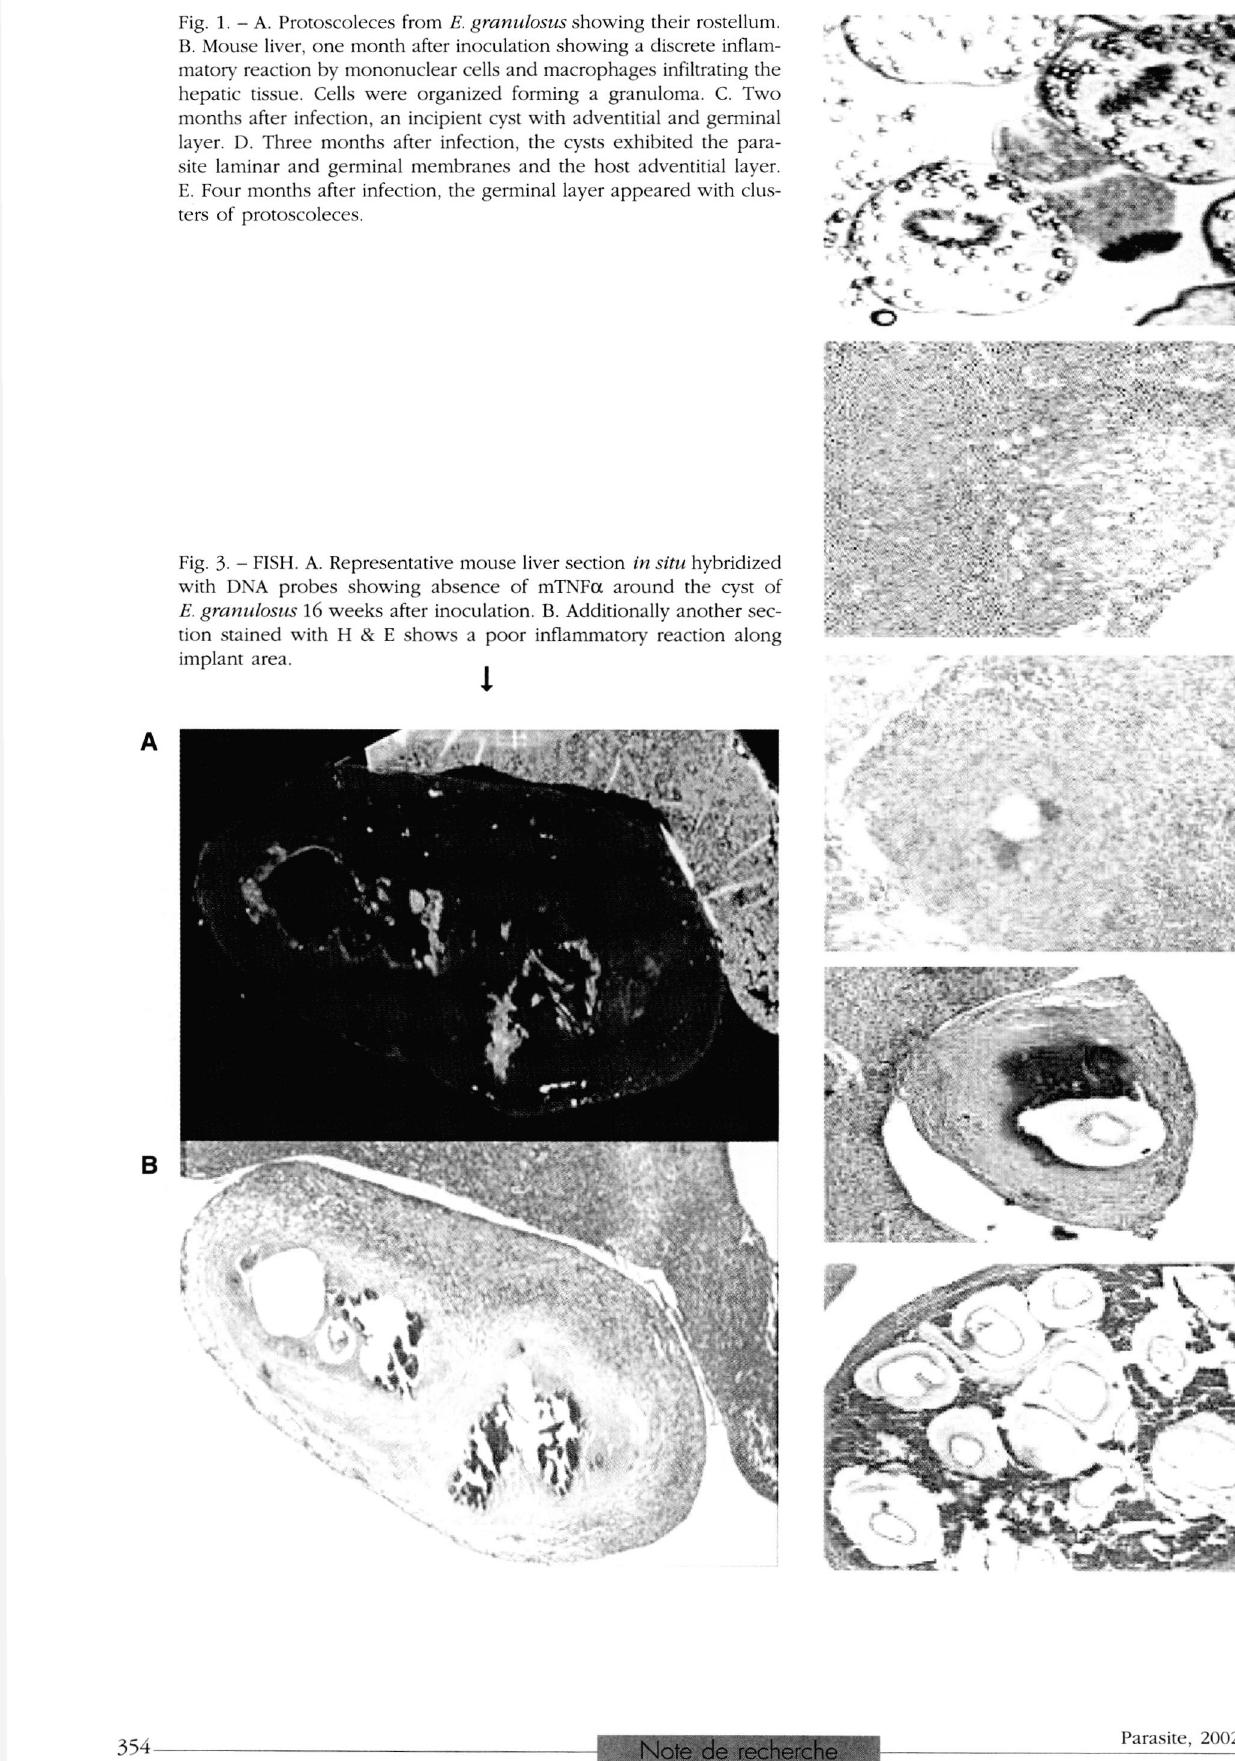
Fig. 1. - A. Protoscoleces from E. granulosus showing their rostellum. B. Mouse liver, one month after inoculation showing a discrete inflam­ matory- reaction by mononuclear cells and macrophages infiltrating the hepatic tissue. Cells were organized forming a granuloma. C. Two months after infection, an incipient cyst with adventitial and germinal layer. D. Three months after infection, the cysts exhibited the para­ site laminar and germinal membranes and the host adventitial layer. E. Four months after infection, the germinal layer appeared with clus­ ters of protoscoleces.